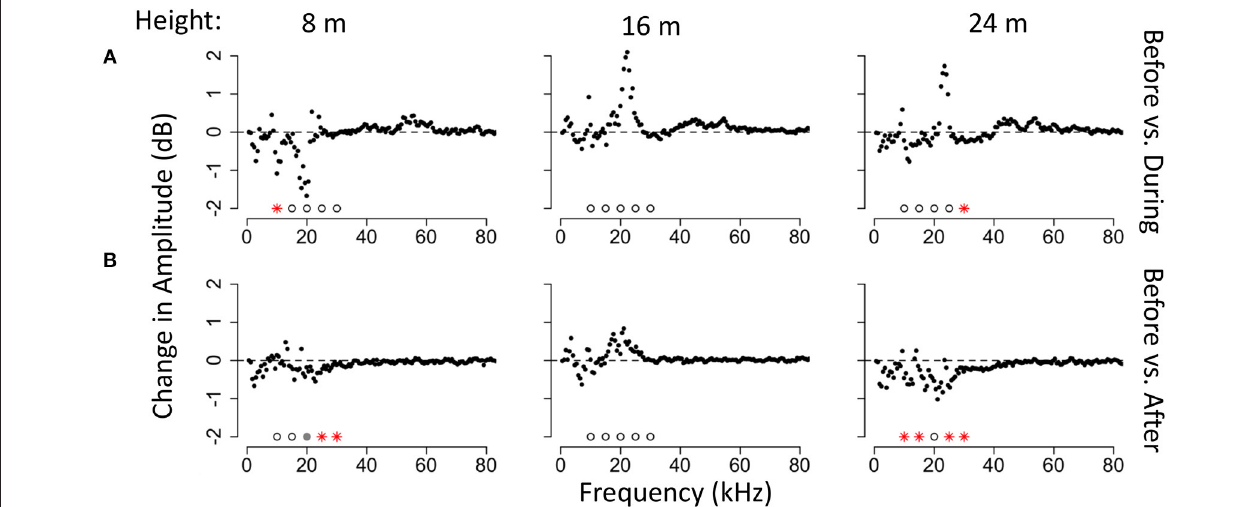
FIGURE 5 | Median changes in amplitude by frequency and height of the recorder. (A) Median amplitude change comparing time bins before and during a bat echolocation sequence. (B) Median amplitude change comparing time bins before and after a bat echolocation sequence. Significance was tested at 5kHz intervals from 10 to 30kHz. Significant differences are shown with red asterisks (Wilcoxon paired ranks sums tests, p < 0.05), marginally significant differences are shown with gray circles (0.05 < p < 0.1), and tests that were not significant are shown with open circles.